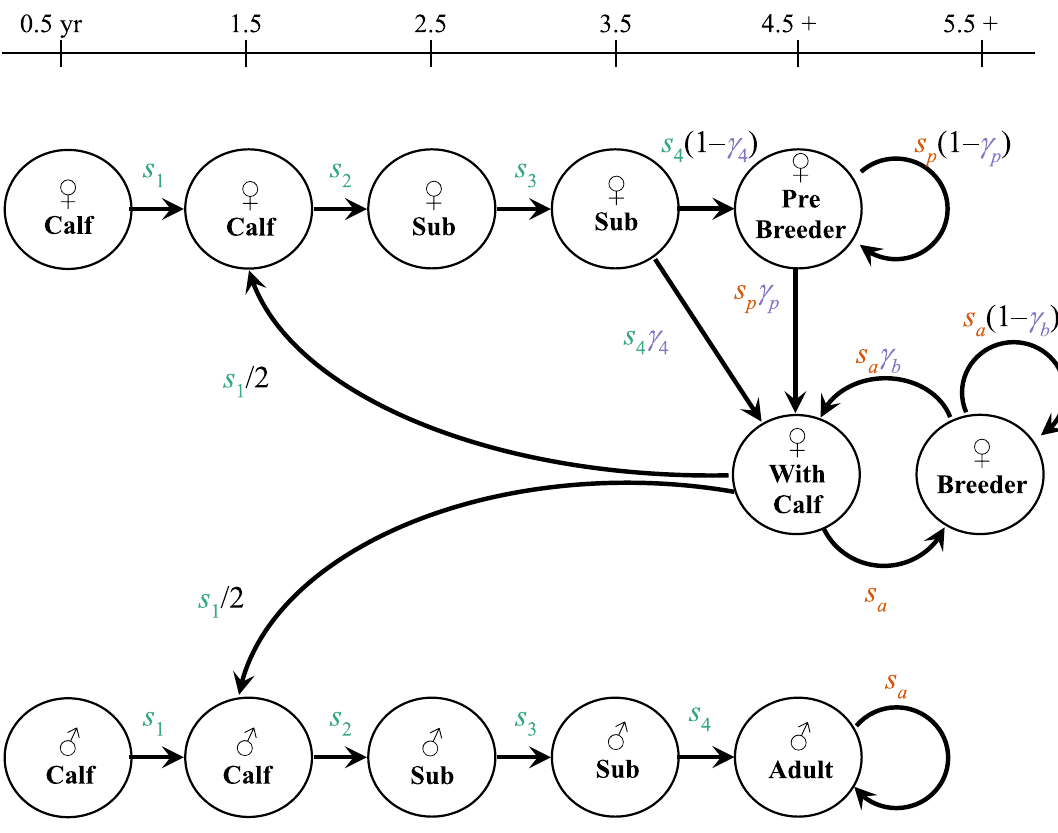
Figure 2. Life cycle diagram of Florida manatees, adapted from Runge et al. 11,23 Stage-specific survival ( s ) and reproductive ( γ ) probabilities govern the transitions between stages. Females ( ♀ ) and males ( ♂ ) are both modeled. Calves enter the population model at age 1.5; until that age they are tracked with their mother (0.5-year-old calves are shown in the diagram for completeness). Color indicates the primary sources of information for parameters within the integrated population model: the parameters in green ( s 1 – s 4 ) are informed primarily by carcass data and surrogate mortality ratio estimates; the parameters in orange ( s p and s a ) are informed primarily by carcass data and mark–recapture survival estimates; and the parameters in purple ( γ 4 , γ p , and γ b ) are informed primarily by mark–recapture reproductive estimates. Other sources of information, including abundance estimates, informed all 2011 and 2016 based on the abundance survey was tempered by consideration of other information, and the difference in those posterior distributions suggests a smoother pattern of population change. All abundance estimates were considerably higher than the aerial synoptic (meaning general view of the whole) survey counts from the same years. Realized population growth rate estimates varied from 0.89 (2013; 0.85–0.93) to 1.05 (2000; 1.03–1.08) with a geometric mean of 1.02 (1.01–1.03; Fig. 4). Point estimates of realized population growth rates were below 1 in only 3 years (2003, 2005, and 2013); in more than half the years the lower credible limit was also